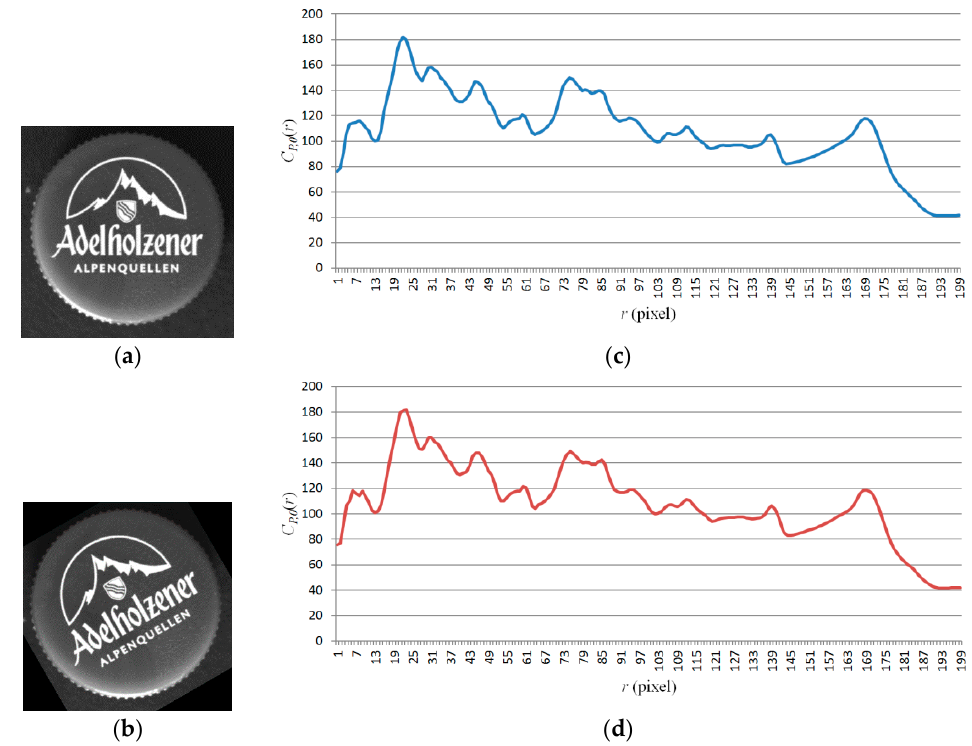
Figure 5. An image at two distinct angles of rotation. ( a ) The original image; ( b ) The rotated image (30° counterclockwise, CCW); ( c , d ) Show the corresponding profiles of ring projection.